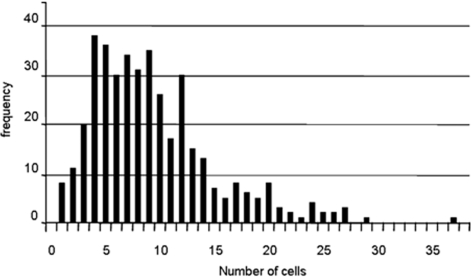
Empirical distribution of root segment length in the proximal zone (state 2 in the stochastic model).